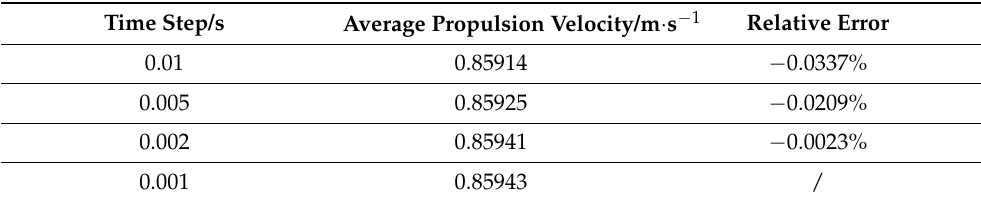
Table 2. Average propulsion velocity under four time